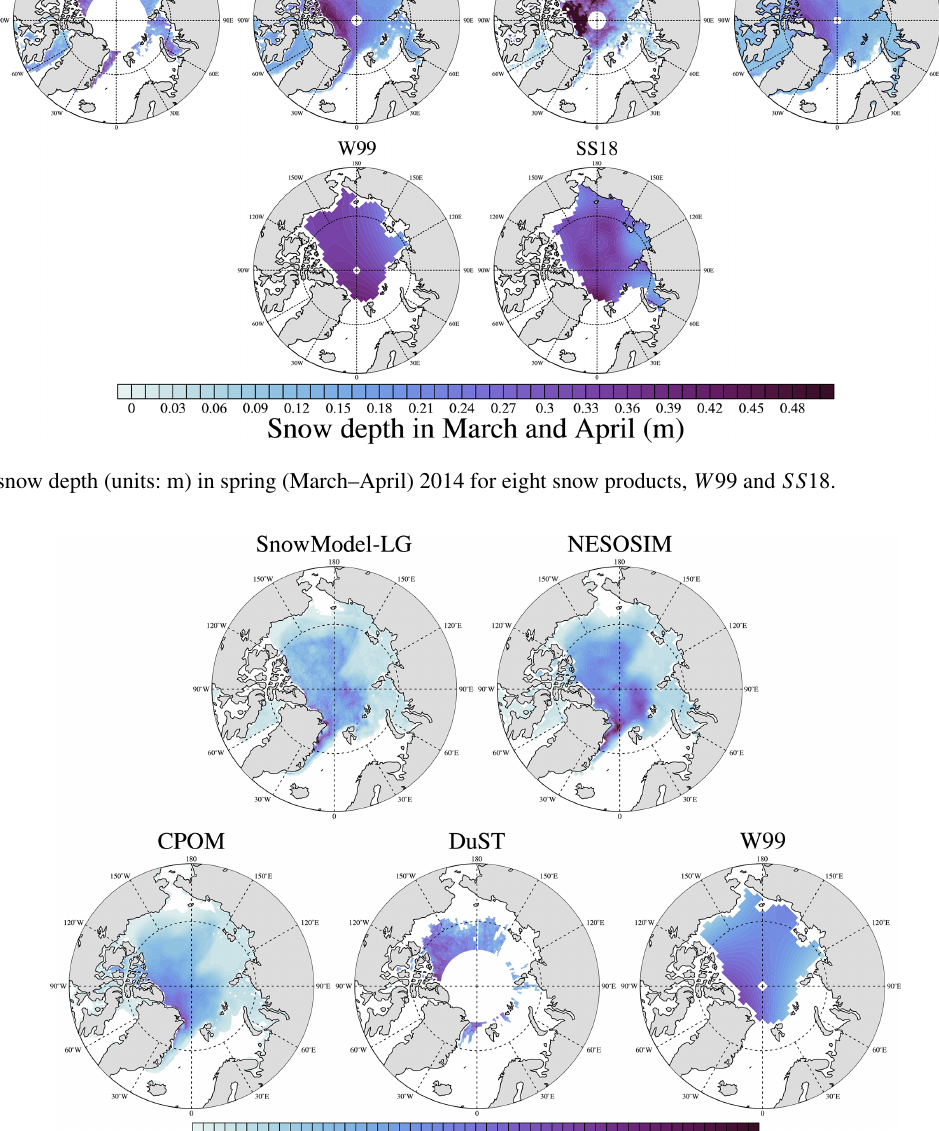
The Cryosphere, 15, 345–367,